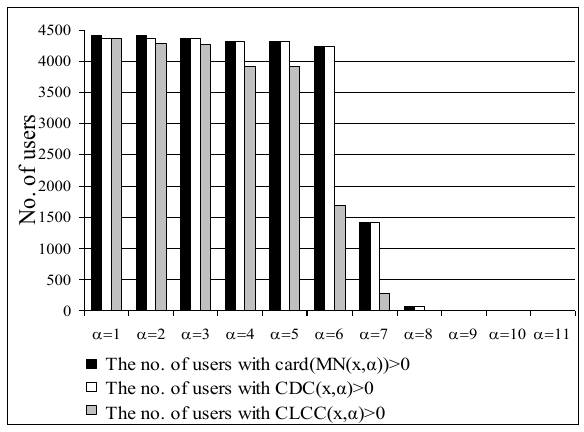
Fig. 2. The number of users in multi-layered neighbourhoods MN ( x,α ) for different α values Next, the cross-layer clustering coefficient and cross-layer degree centrality were calculated. Both measures were evaluated separately for 11 different values of parameter α i.e. 1, …, 11. Similarly to MN ( x , α ), the number of non-zero values of CDC ( x , α ) and CLCC ( x , α ) for different α are presented (white and grey columns respectively in Figure 2).